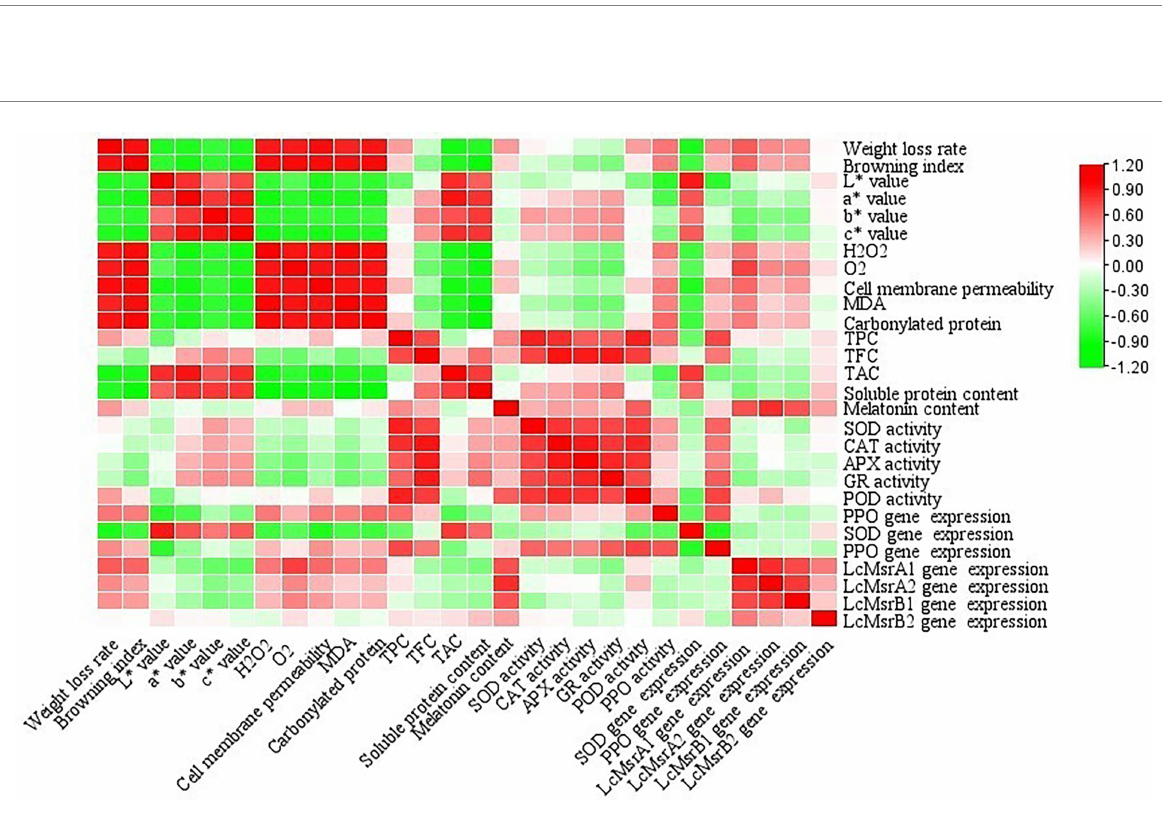
FIGURE 7 Correlation coefficients of the selected biochemical parameters determined in the litchi samples during cold storage. Different color scales indicate the different correlation coefficients.